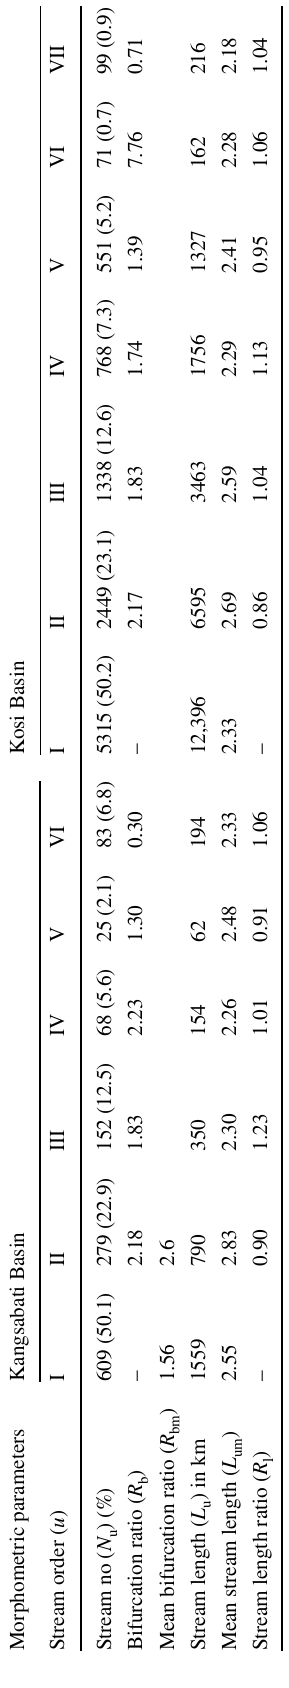
reaches and consistency of stream length throughout the basin is indicative of mature to old geological formation and sufficient morphological adjustment throughout the basin. ) is the characteristics prop- Mean stream length (L sm erty of drainage network and associated surface